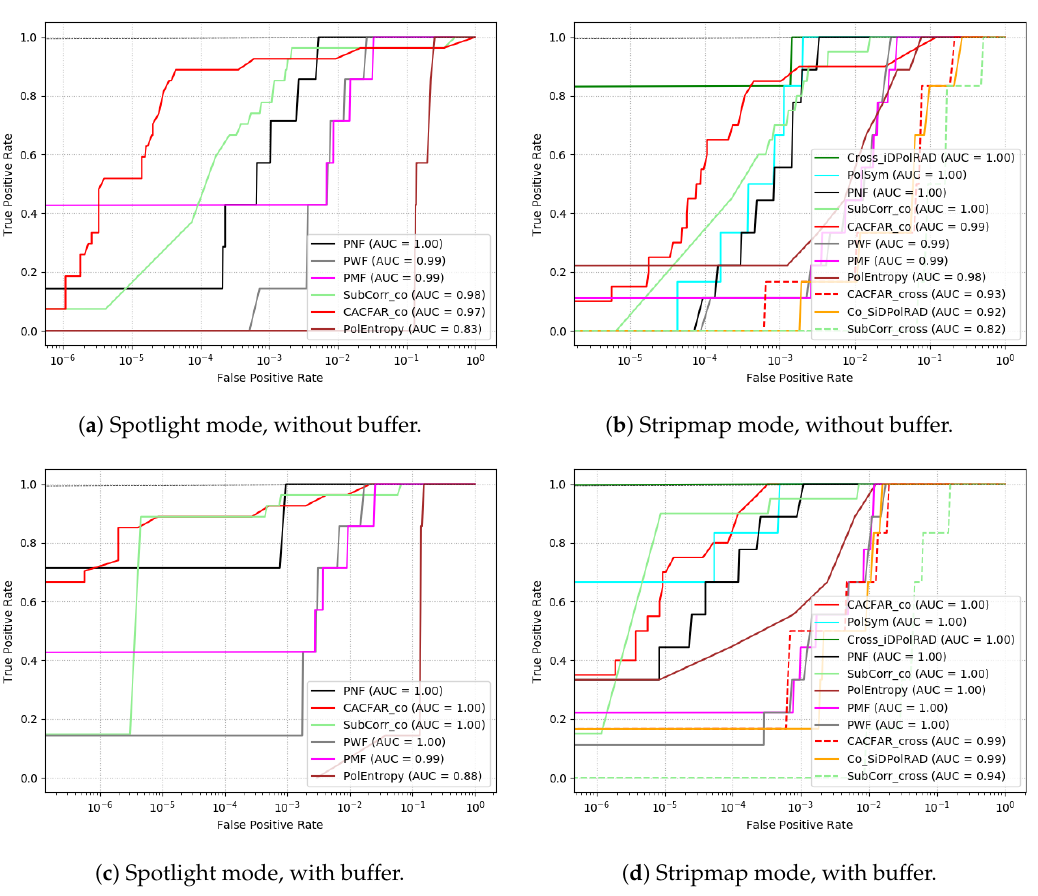
Figure 10. Object-detection: impact of the usage of a buffer around the boat on ROC curves for different TSX-modes (multilooked, false positives in log10